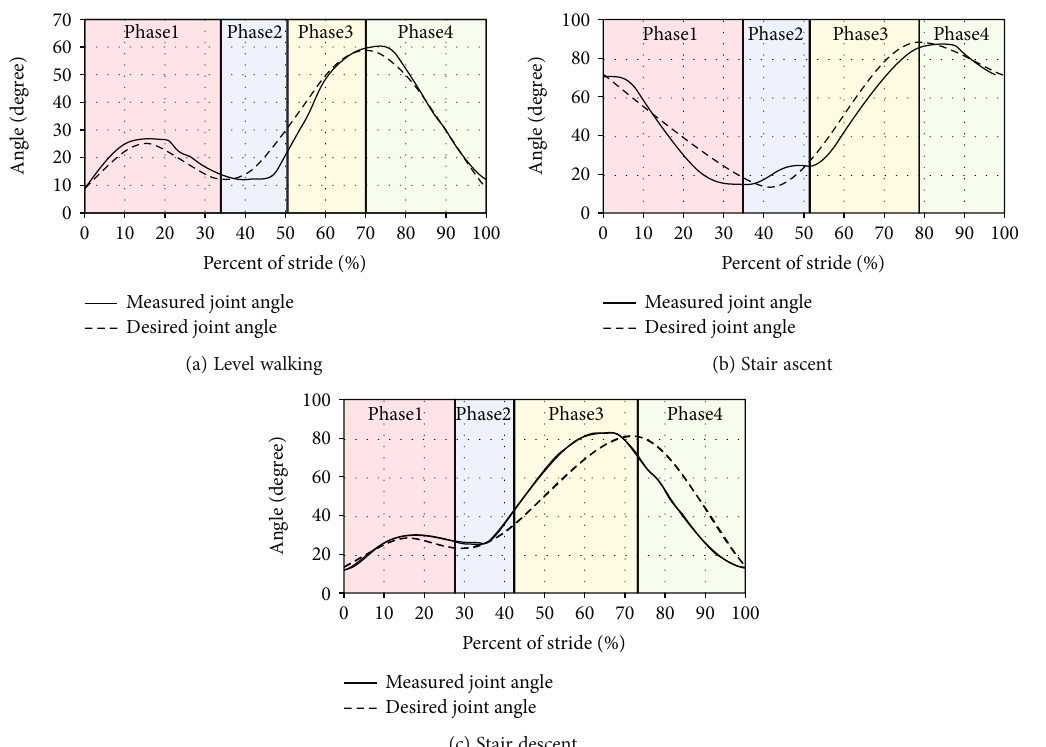
Figure 17: Comparison between the desired motion and the actual drive